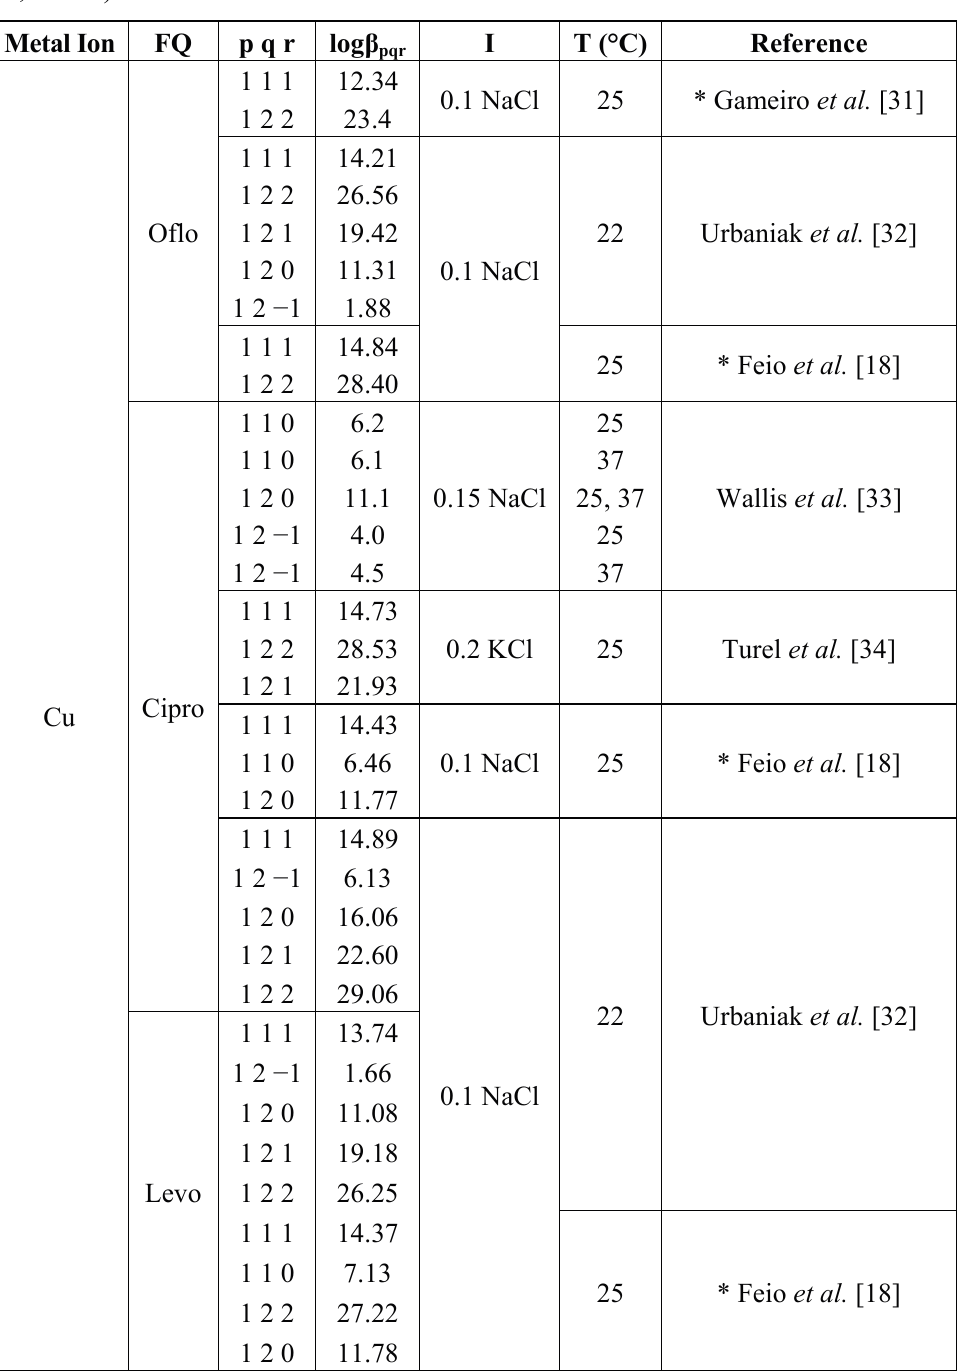
(FQ) H calculated p q r